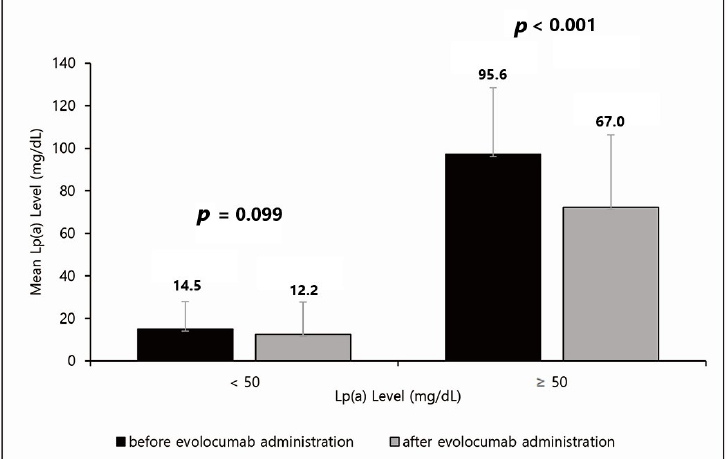
Figure 1. Effect of evolocumab based on an Lp(a) level of 50 mg/dL. In patients with Lp(a) < 50 mg/dL, Lp(a) levels decreased by approximately 16%, from 14.5 mg/dL to 12.2 mg/dL, but this difference was not significant ( p = 0.099). In patients with Lp(a) ≥ 50 mg/dL, Lp(a) levels decreased significantly by approximately 30%, from 95.6 mg/dL to 67.0 mg/dL ( p < 0.001). Lp(a), lipoprotein(a). Table 1. Clinical characteristics.